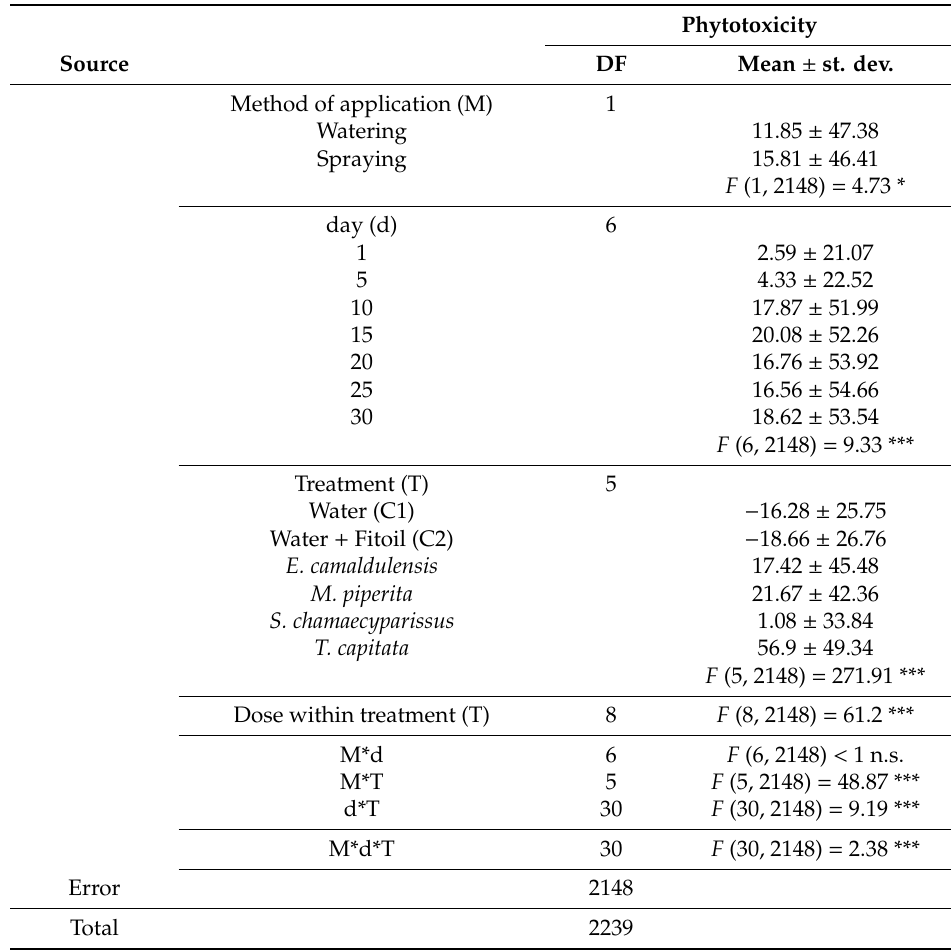
Table 2. Phytotoxicity level (mean ± standard deviation of main e ff ects) and results of ANOVA on Erigeron bonariensis plantlets exposed to four EOs, applied by watering or spraying, at di ff erent doses and evaluated at 1, 5, 10, 15, 20, 25, and 30 days after